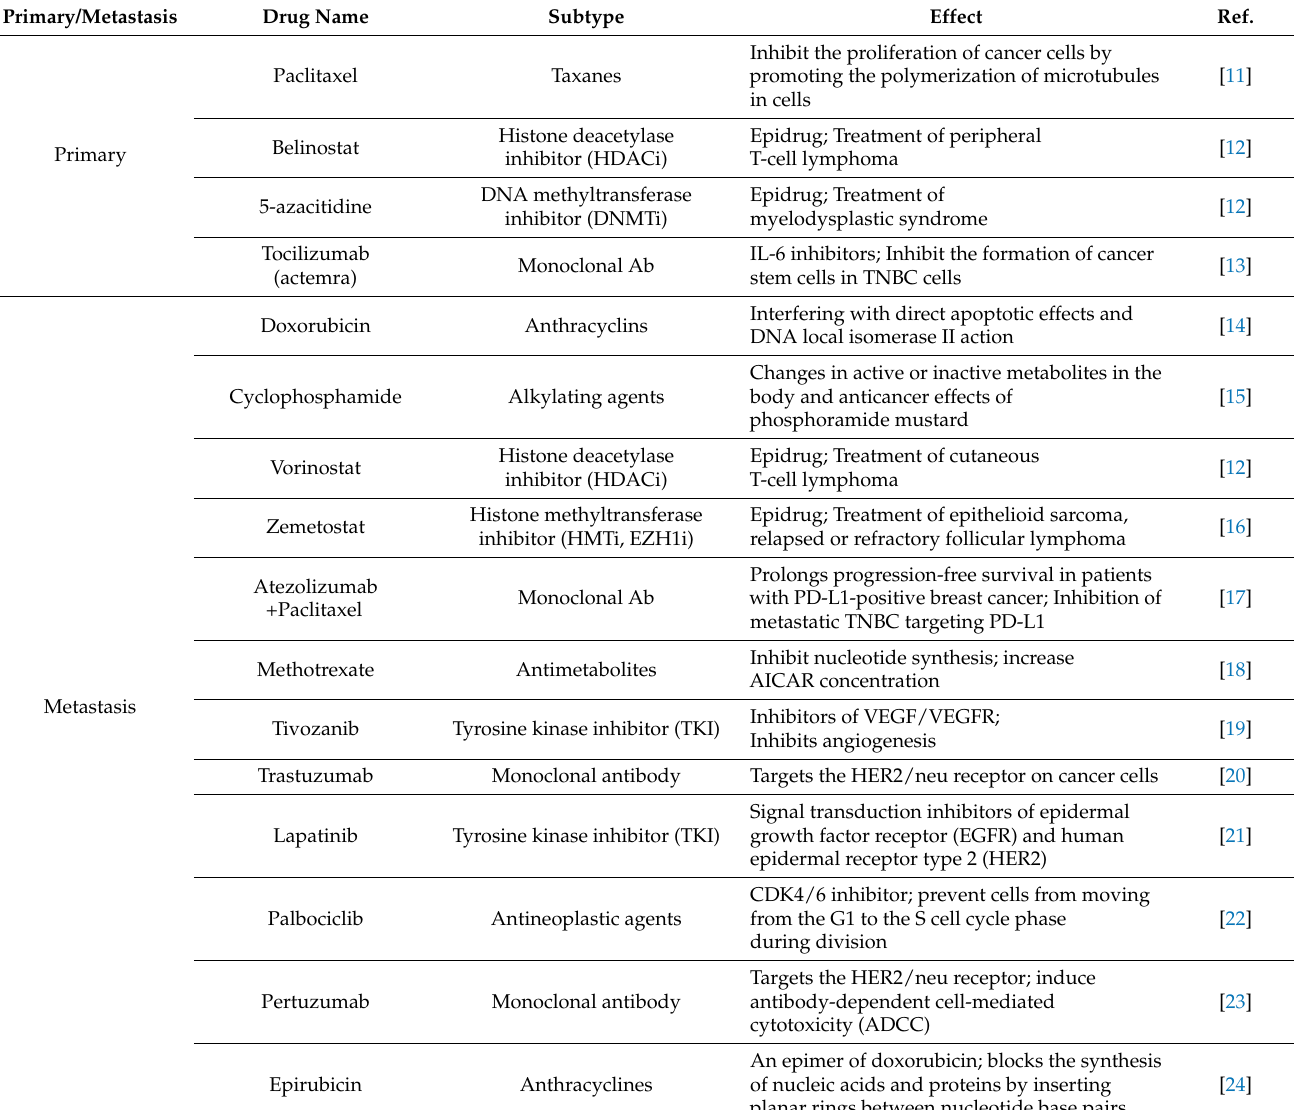
Table 1. The FDA-approved drugs in primary and metastatic breast